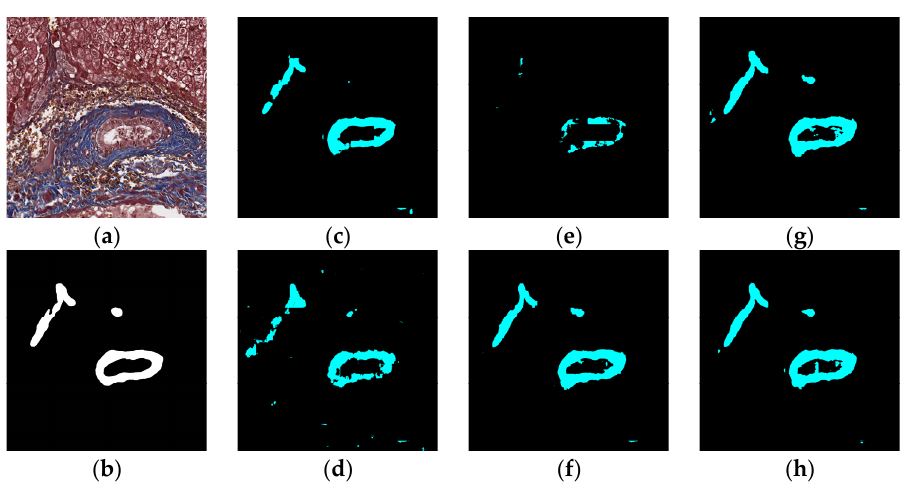
Figure 11. Segmentation results for big bile ducts and bile ductules near hepatocyte area: original ( a ), GT ( b ), FCN ( c ), SegNet ( d ), U ‐ Net ( e ), Deeplabv3 ( f ), Deeplabv3 ‐ plus ( g ), and the proposed network ( h ).